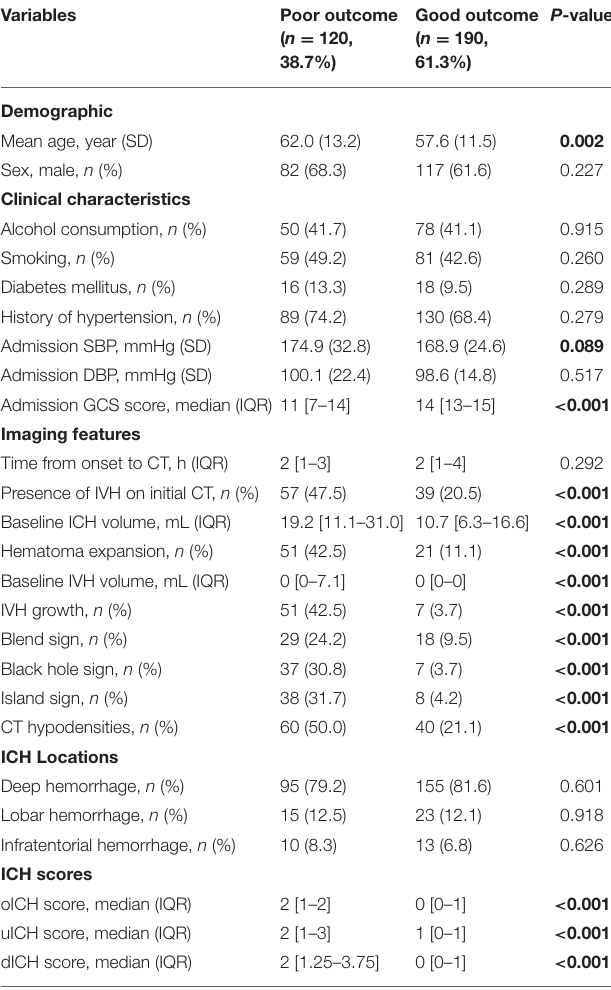
TABLE 1 | Comparison of demographic, clinical, and imaging characteristics and outcome between patients with and without poor outcome.